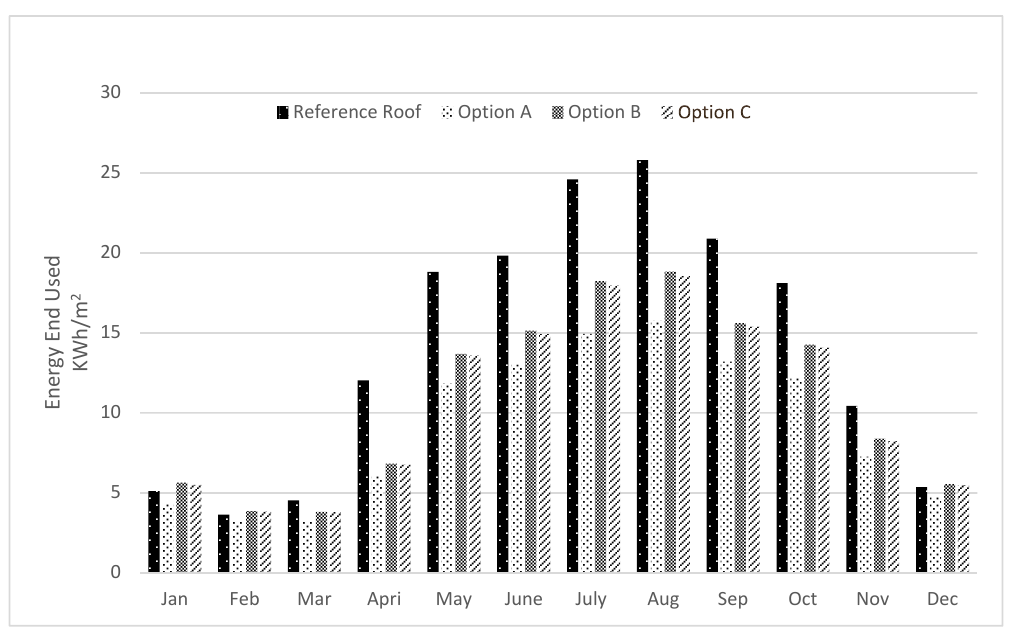
Figure 5. Monthly energy consumption of green roof options.